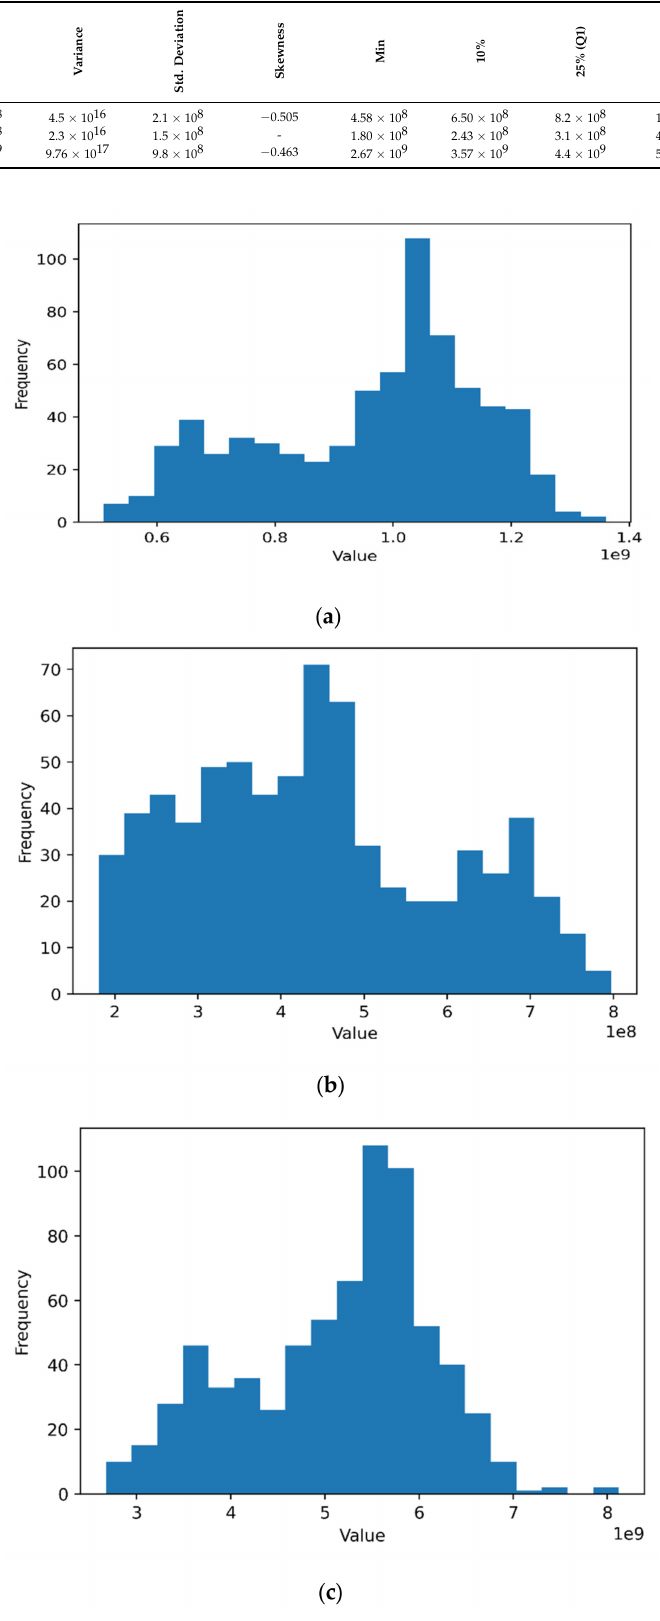
Figure 4. Dataset histograms: ( a ) LTE, ( b ) MPLS, and ( c ) upstream